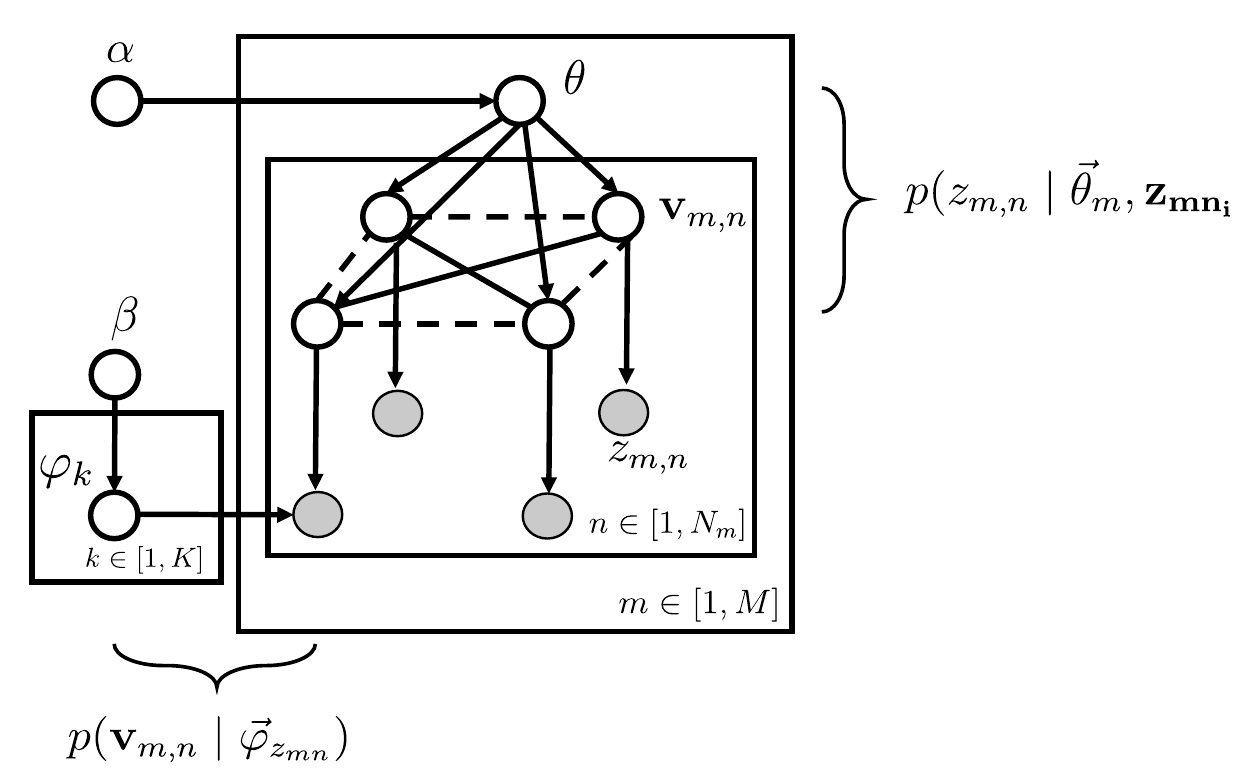
Figure 4. Graphical model of LDA with spatial